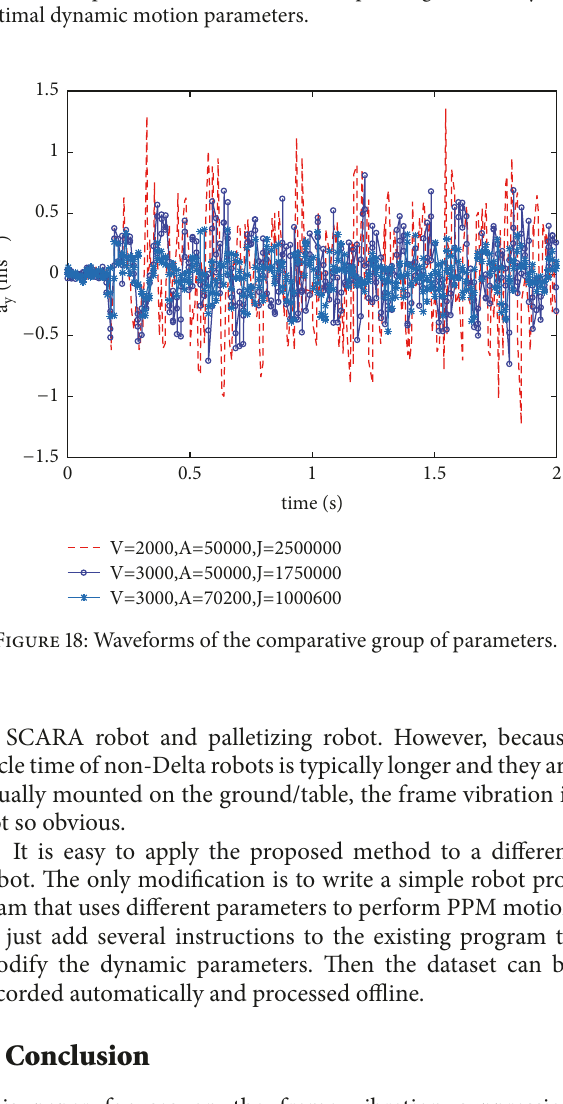
Figure 17: Spectrum of the acceleration profile generated by the optimal dynamic motion parameters.